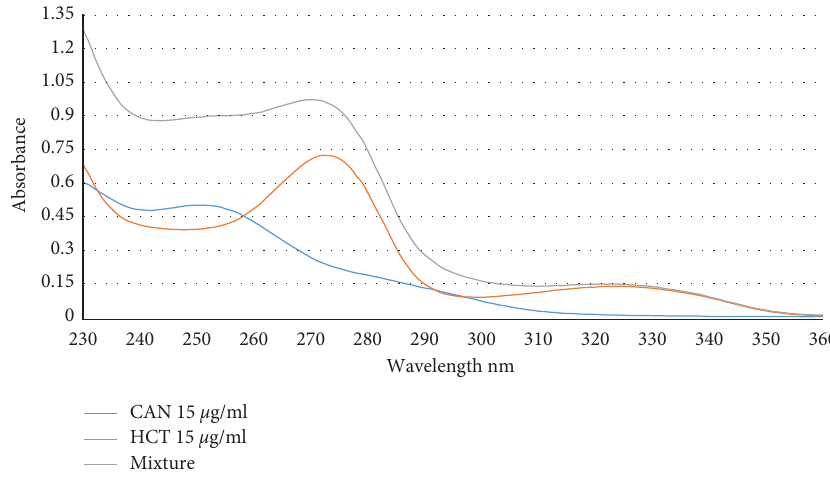
Figure 3: Absorption spectra of 15 µ g/ml candesartan cilexetil and 15 µ g/ml